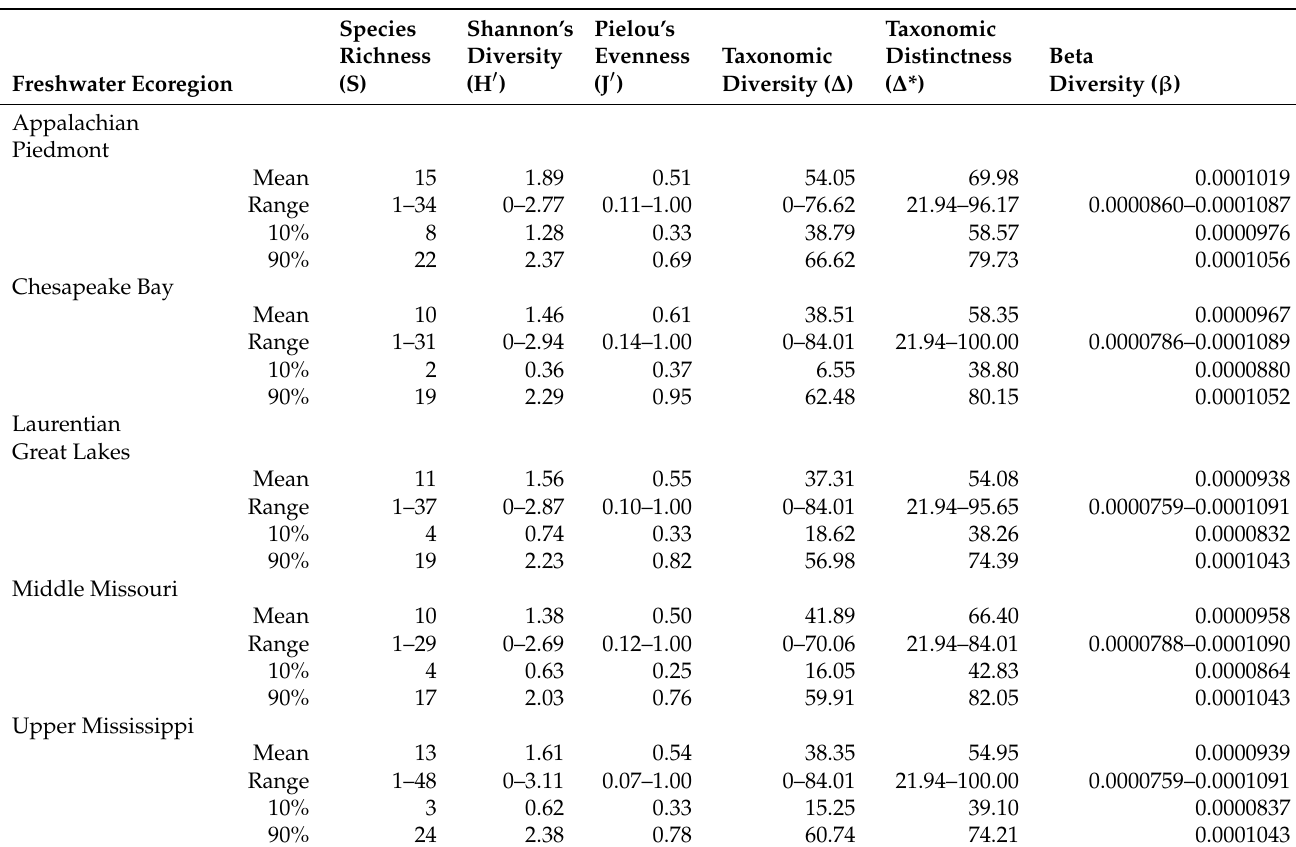
Table 2. Descriptive statistics (i.e., mean, range, and 10th and 90th percentiles) of fish biodiversity indices in five freshwater